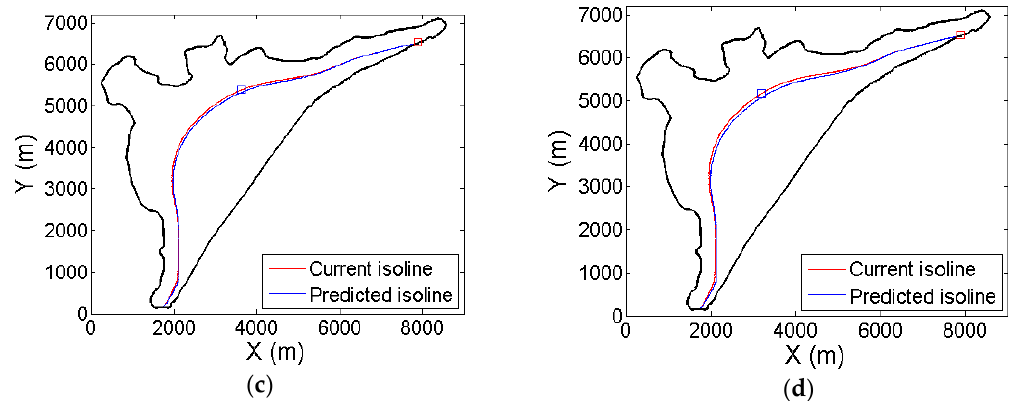
Figure 7. Position of the 100 meter level set of the seawater/freshwater interface using a multiplication coefficient for the extraction of ( a ) 1.25, ( b ) 1.5, ( c ) 1.75, and ( d ) 2.